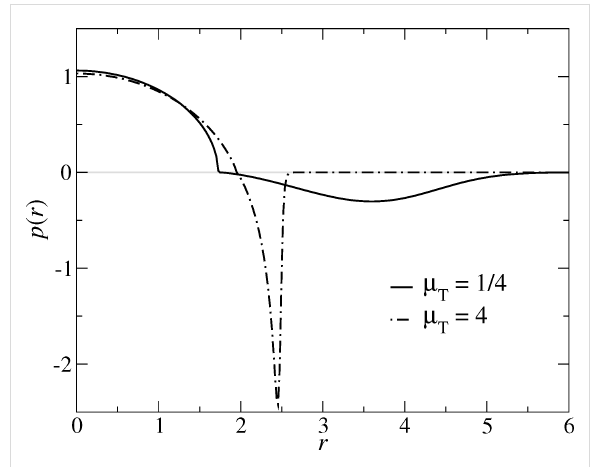
Figure 7: Pressure p ( r ) in the Gauss model at zero load for two different Tabor coefficients as a function of the in-plane distance r from the center of the contact. The contributions due to the constraint are positive, i.e., above the grey line, while the adhesive forces are nega-